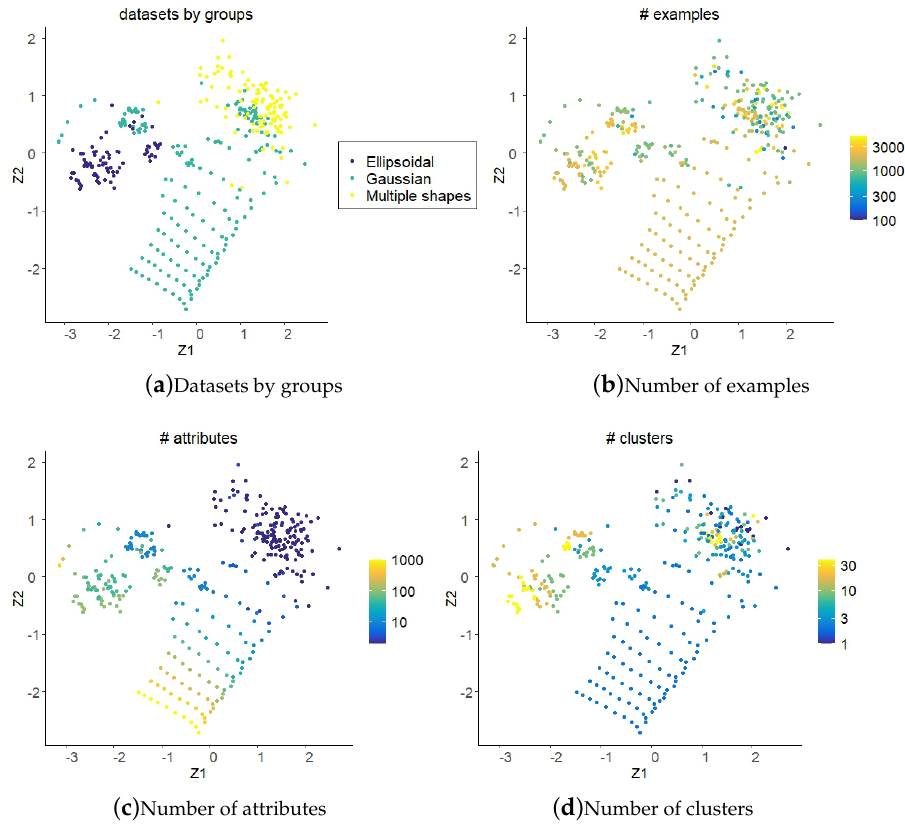
Figure 4. Characteristics of the datasets projected in the instance space, color coded according to ( a ) distribution of the datasets by groups, ( b ) number of examples, ( c ) number of attributes and ( d ) number of clusters represented by ground truth. The characteristics have been log 10